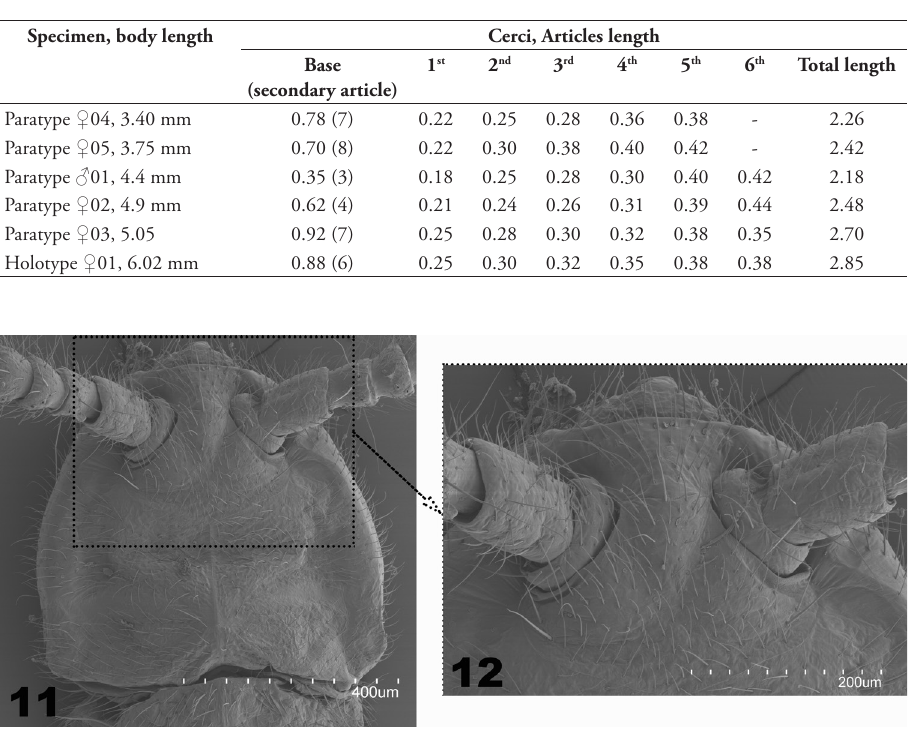
Table 2. Haplocampa wagnelli Sendra, sp. n., length of cercal articles and total length (units in mm) including number of articles of each